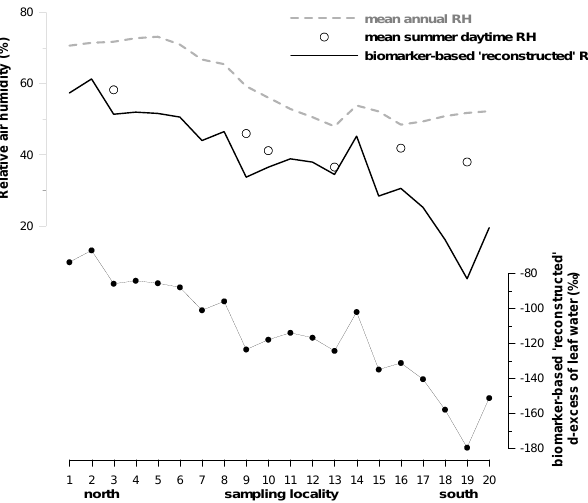
Figure 6. Comparison of biomarker-based reconstructed relative humidity (RH) values with actual RH values (mean annual RH re- trieved for all investigated sites from GeoINTA, 2012; mean sum- mer daytime RH for six stations retrieved from